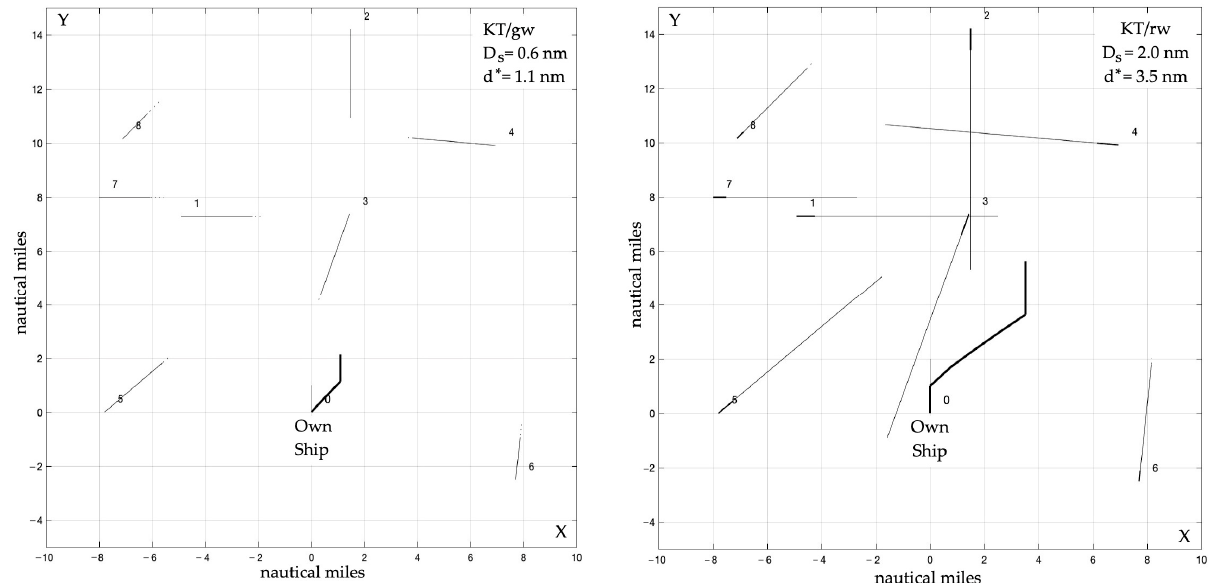
Figure 16. Safe kinematic trajectory of one’s own ship determined by the KT algorithm, in good (gw) and restricted (rw) visibility at sea; d* means the final deviation of the course of one’s own ship from the initial value after exiting the collision situation.